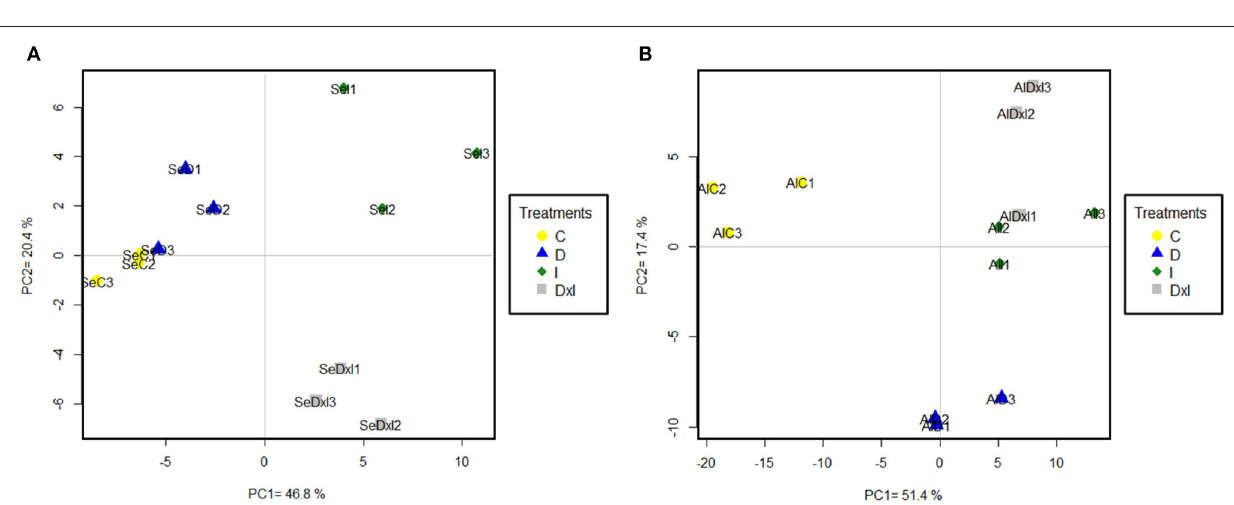
Frontiers in Plant Science |